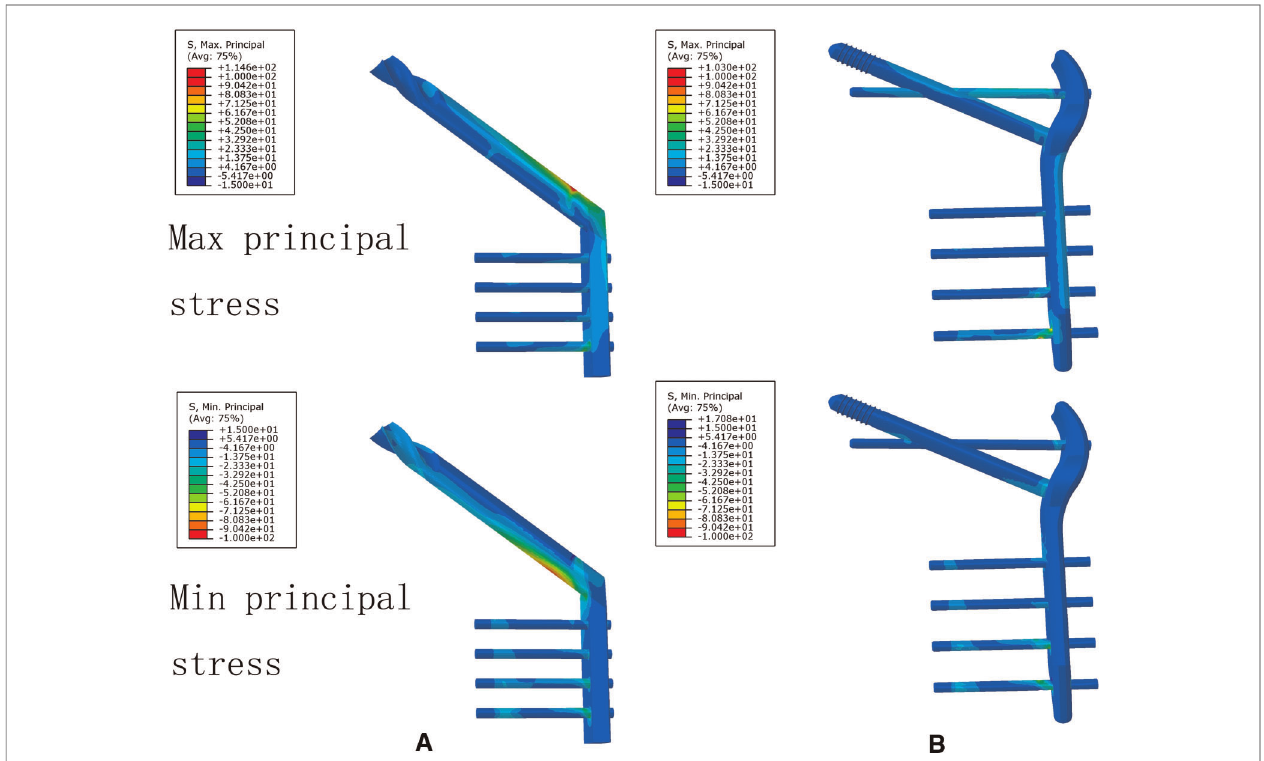
FIGURE 10 | The maximum principal stress and minimum principal stress extremes of two implant models for the treatment of a stable intertrochanteric fracture. The fi gure shows that the TSFP has improved the maximum principal stress distribution compared with DHS for the fi xation of Evans type I intertrochanteric